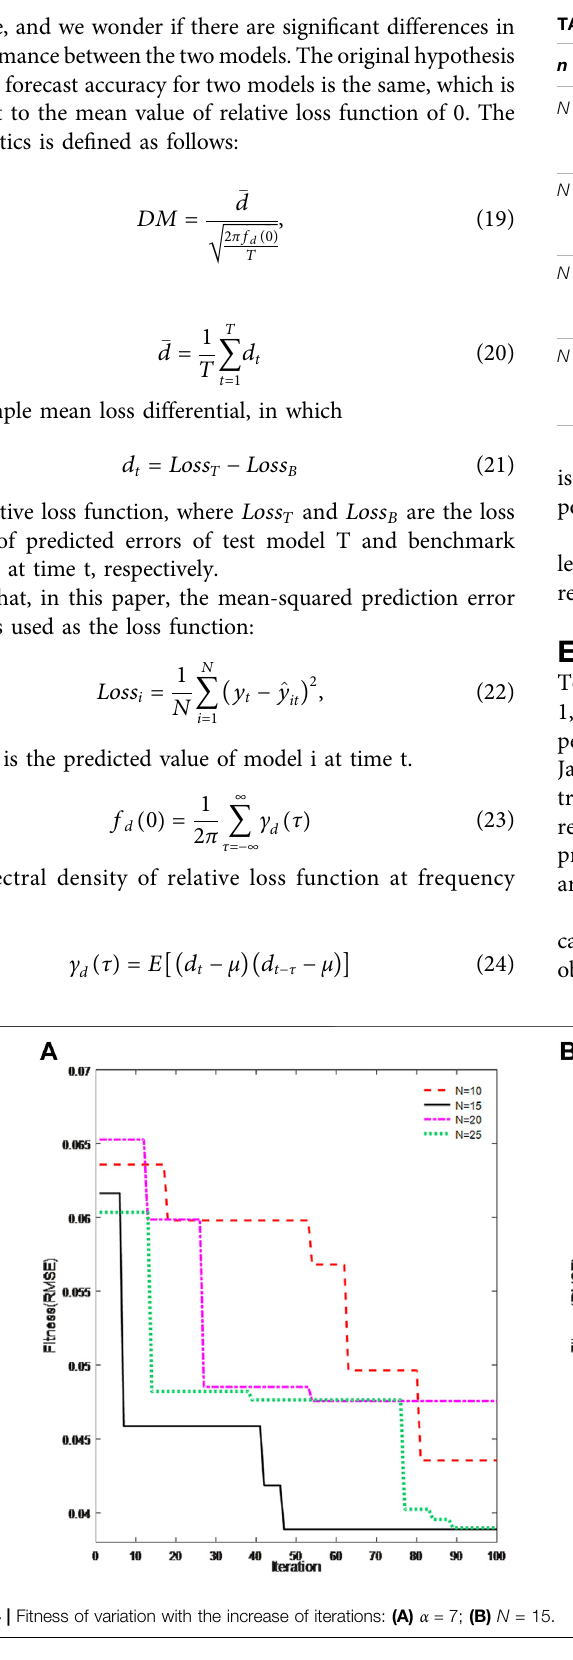
Frontiers in Environmental Science |